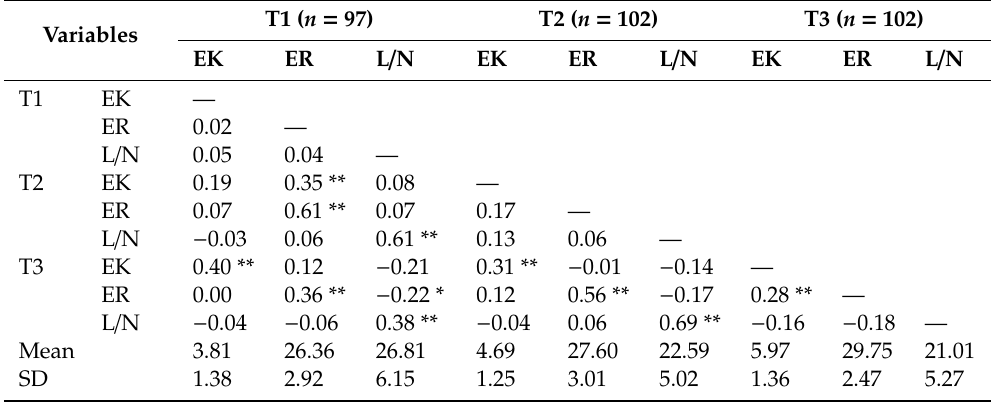
Table 1. Descriptive statistics and correlations among the study variables.